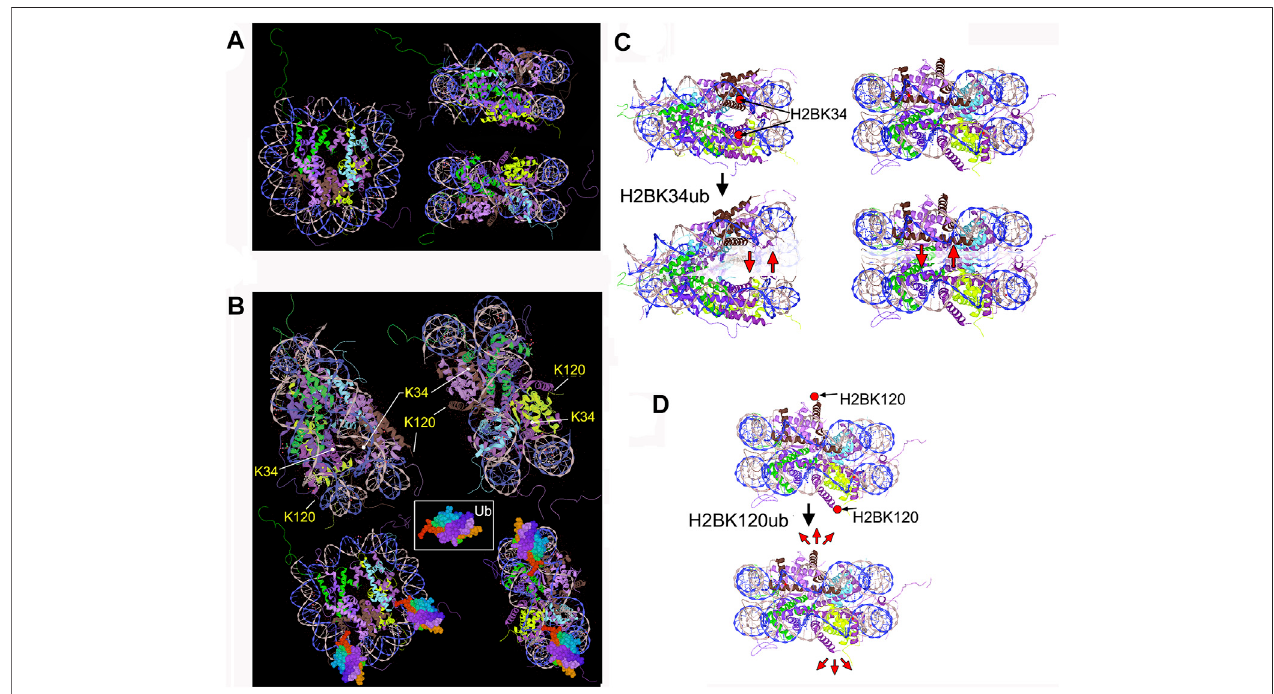
FIGURE1|(A) Nucleosome(1kx5)front,top,andsideview. (cid:129)(cid:129) H3.2(chainsA,E), (cid:129)(cid:129) H2B1.1(chainsD,H), (cid:129)(cid:129) H2Atype1(chainsC,G),and (cid:129)(cid:129) H4(chainsB,F) (B) Positions of H2B K34 and K120 indicated by arrows. Drafts at the bottom illustrate the H2BK34ub nucleosome (Ubiquitin PDB: 1ubq). (C,D) Sketches, depicting the potentialmechanisms ofnucleosome-destabilizing effects byH2BK34-/ K120-ubiquitylation. (C) H2BK34ub installed intheoccludednucleosomeregioncould actasa “ wedge ” , facilitating DNA gyre – gyre separation ( “ gaping ” ). (D) Mechanistic forces applied to the H2A-H2B dimer by ubiquitin deposited to H2B termini could weaken the nucleosome through stochastic motions of bulky ubiquitin and/or its steric clashes with the nucleosome surface. This could also promote nucleosome breathing and DNA-dimer opening